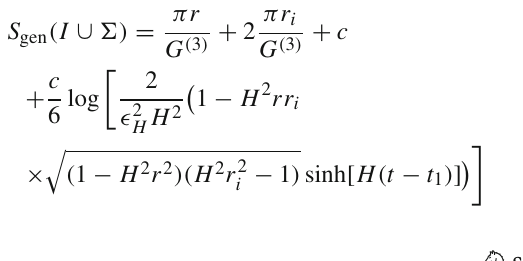
Wecanalsounderstandthenonexistenceoftype1islandin amoredirectway.AssumingthequantumstateontheCauchy slice to be pure, S mat ( I ∪ (cid:11)) is identified with S mat (( I ∪ (cid:11)) c ) , the matter entropy on the red dashed line in Fig. 6.